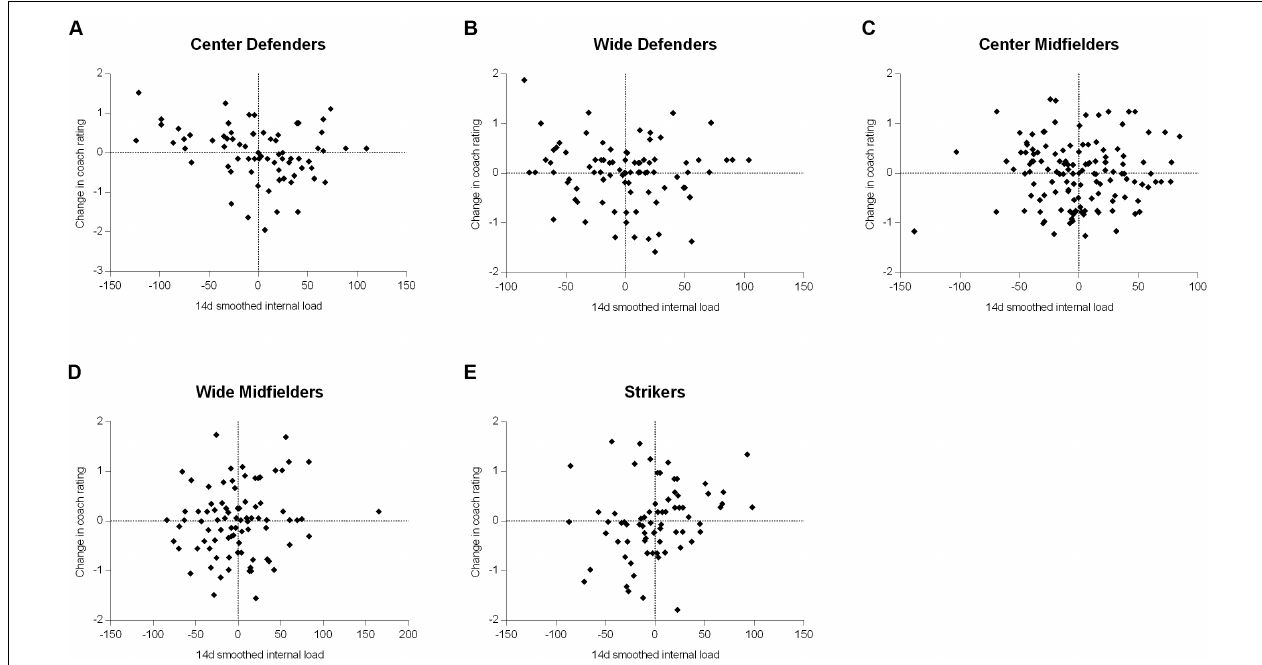
FIGURE 2 | Scatter plot distribution of the change in coach rating for a given change in 14-day smoothed internal load for the different playing positions of (A) center defenders, (B) wide defenders, (C) center midfielders, (D) wide midfielders, and (E)